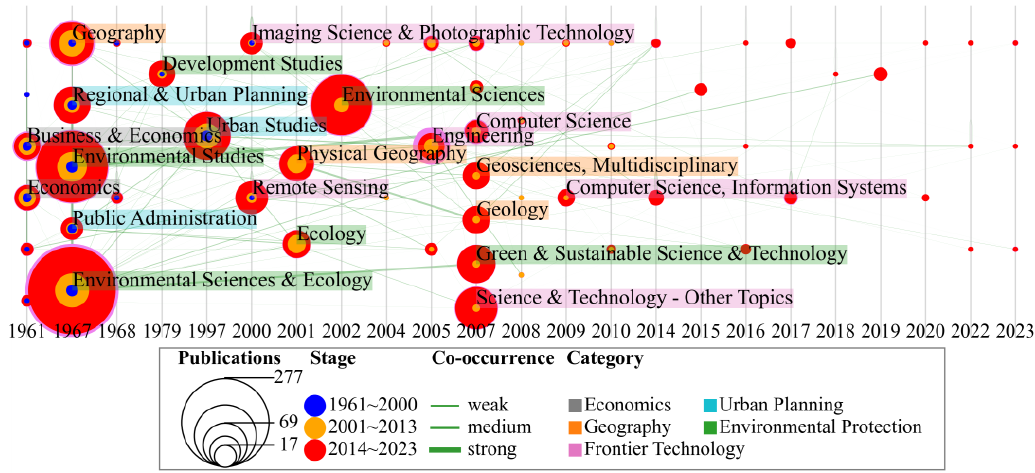
Figure 4. Development of primary DAUE-related WOS categories.